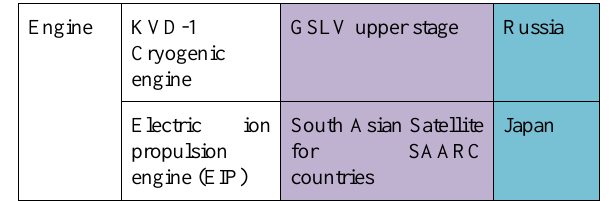
Table-1. Collaboration for components for Launch vehicles and Launch Services. Green color indicate that India is providing service and blue color indicate that India receives service / technology from international community, yellow color indicates joint development. Pink color indicates short term and lavender color indicates medium to long term cooperation.